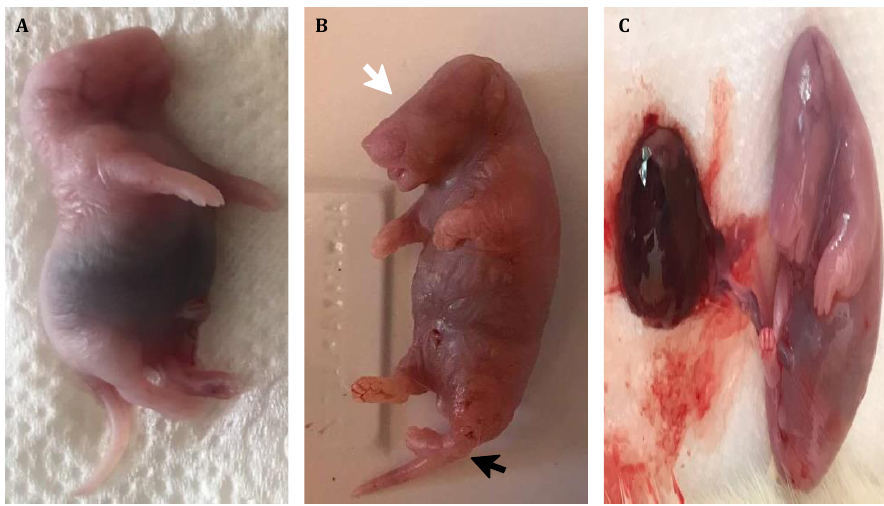
Figure 2. Photographs of rat fetuses from control group ( A ), received distilled water; carvedilol- methotrexate combination group ( B ), showing microcephaly (white arrow) and curved legs (black arrow); carvedilol-methotrexate combination group ( C ), showing hemorrhagic